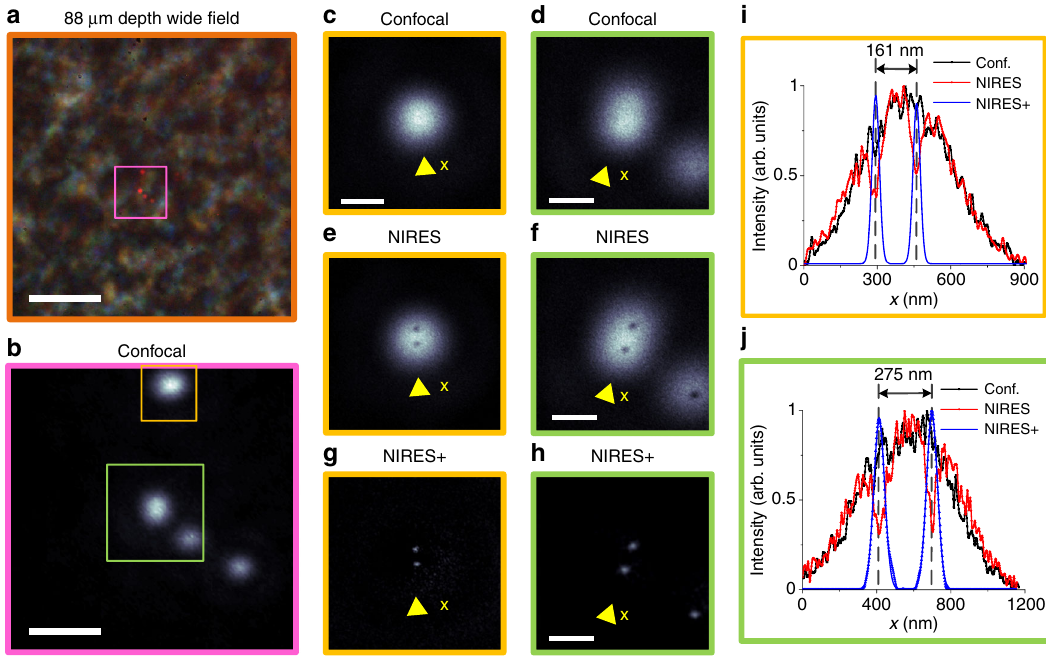
Fig. 5 NIRES nanoscopy for super resolution imaging of single UCNPs through deep mouse liver tissue. a Bright fi eld and fl uorescence wide fi eld image of UCNPs at 88 µ m depth inside a mouse liver tissue slice. b Confocal images of a 6 μ m × 6 μ m area containing clusters of UCNPs. c and d are the zoom-in confocal images of two areas of interest from b . e and f are the raw data of NIRES images of c and d . g and h are the processed data of NIRES + images of e and f . i Line pro fi les of UCNPs from the confocal image ( c ), raw NIRES image ( e ), and positive NIRES image ( g ). j Line pro fi les of UCNPs from confocal image ( d ), raw NIRES image ( f ), and positive NIRES image ( h ). Pixel dwell time for confocal and NIRES is 3 ms. The Pixel size for confocal and NIRES is 10 nm. The scale bar is 8 μ m in a and 1.5 μ m in b and 500 nm in c – h . Note that the excitation power density to achieve the best resolution (see Supplementary Fig. 10 & 11) in the depth of 88 μ m is 5.5 MW cm − 2 , to compensate the scattered excitation power through the thick